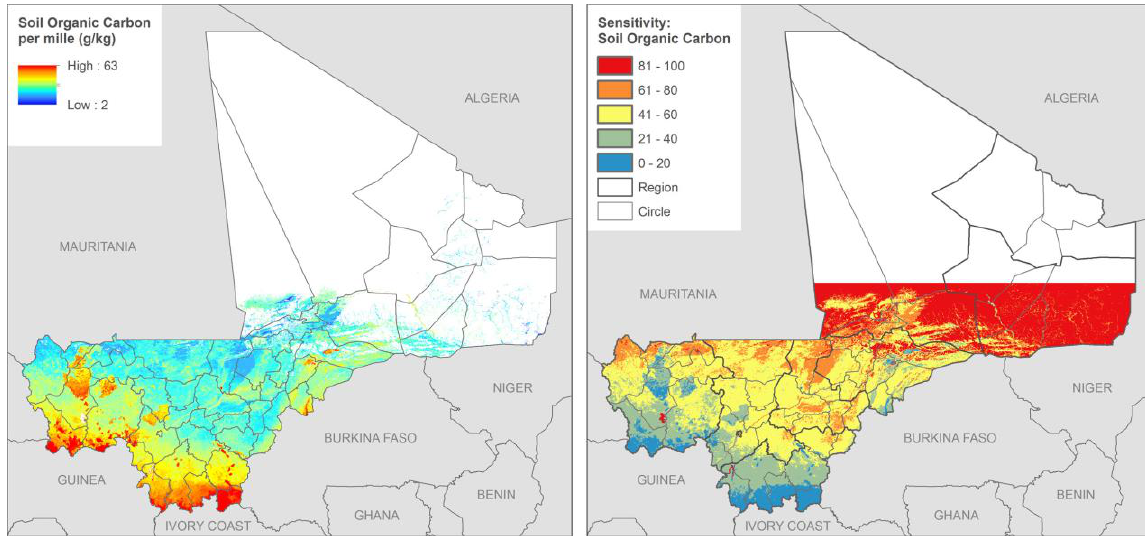
Figure 4. Soil Carbon Partly Derived from MODIS data raw data ( left ) and transformed ( right ).